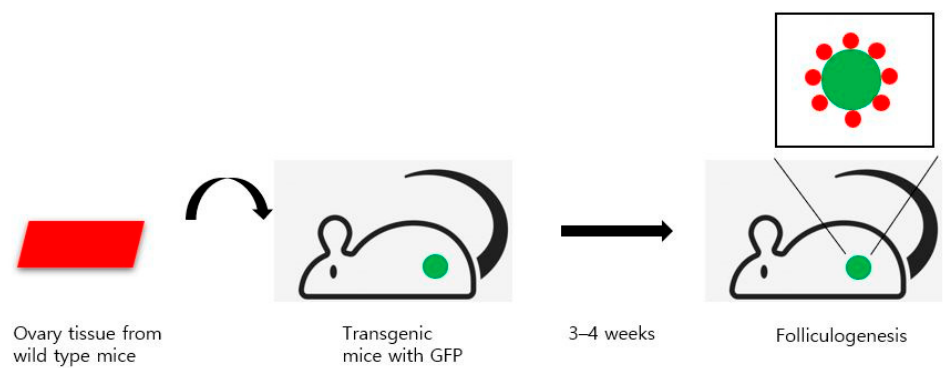
Figure 1. The experiment using transgenic mice with GFP by Tilly et al.: folliculogenesis in postnatal life. Wild type ovaries grafted into transgenic female mice with green fluorescent protein (GFP) were infiltrated with GFP-positive germ cells that formed follicles. After 3 to 4 weeks, GFP-positive oocytes were surrounded by wild-type granulosa cells, indicating that ovarian stem cells from the GFP mice had initiated folliculogenesis.